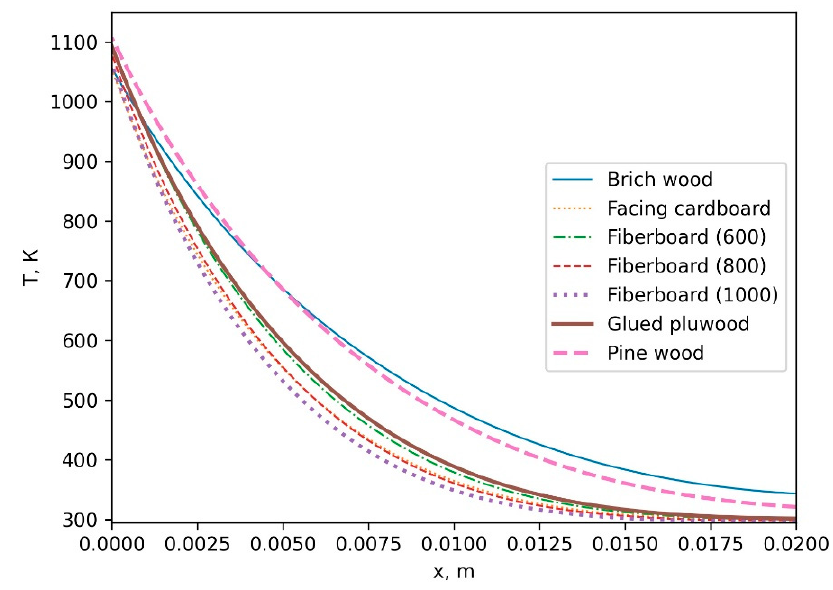
Figure 14. Impact of surface forest fires (high intensity) on various materials from a distance of 20 m for 350 s of exposure—temperature distribution along the wall thickness.